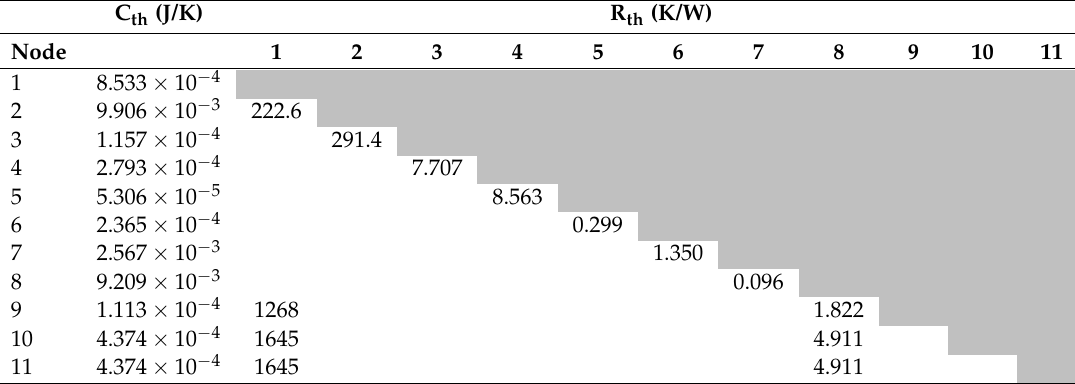
Table 3. Optimized thermal capacitance values and thermal resistance values of the LED CTM. C th (J/K) R th